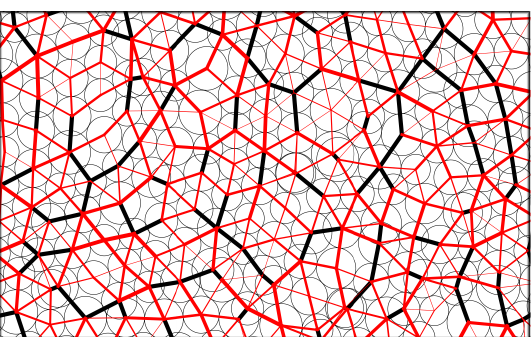
Figure 1: A snapshot of a configuration of linear disks at packing fraction φ = 1. The contact network is in red while the overlap network is in black. The thickness of the lines reflects the intensities of forces. While black lines carry all forces equal to one, red lines, associated to contacts, carry a varying force in the interval [ 0, f